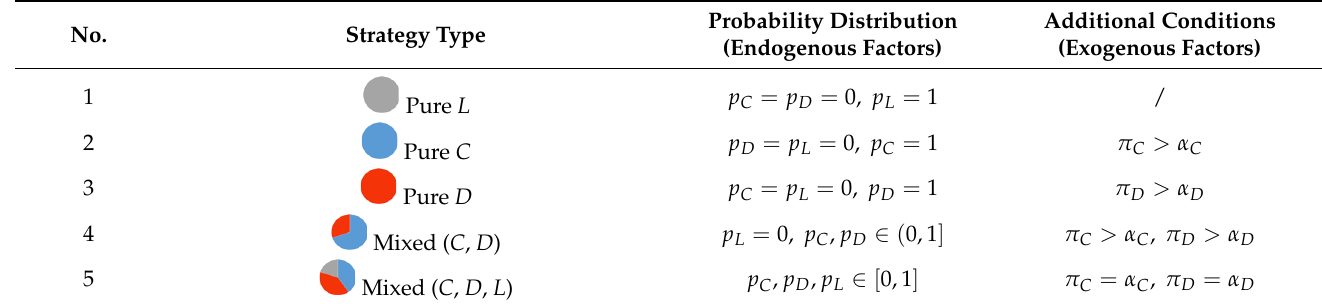
Table 1. Essential conditions for an individual’s stable strategy.